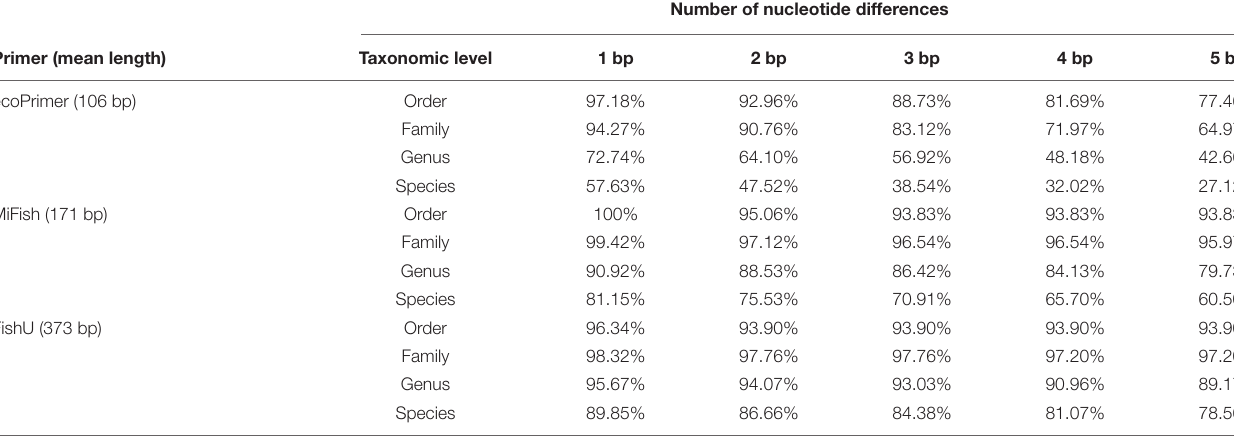
TABLE 2 | Percentage of accurately assigned taxa in three fish barcodes by the different